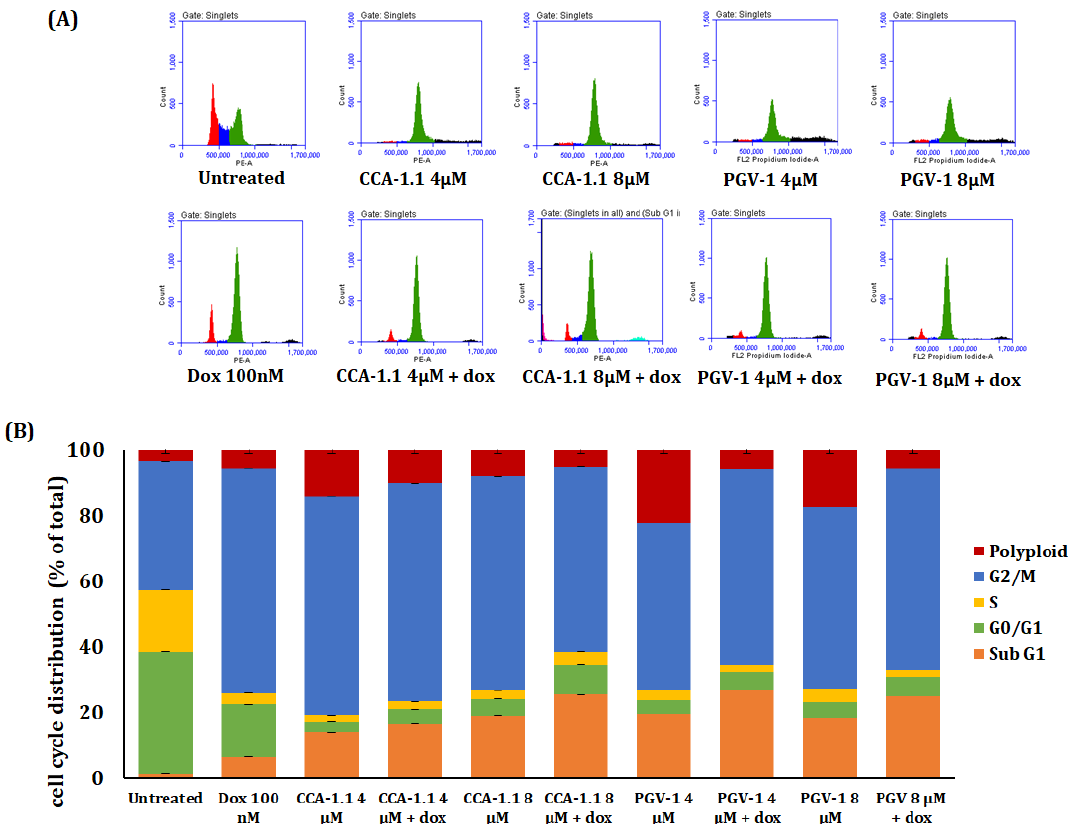
Figure 3. Effects of CCA-1.1, PGV-1, CCA-1.1 + doxorubicin (Dox) on the cell cycle profile of T47D cells. Cells (2 × 10 5 cells/well) were treated with CCA-1.1, PGV-1, or Dox for 24h, stained with PI as described in